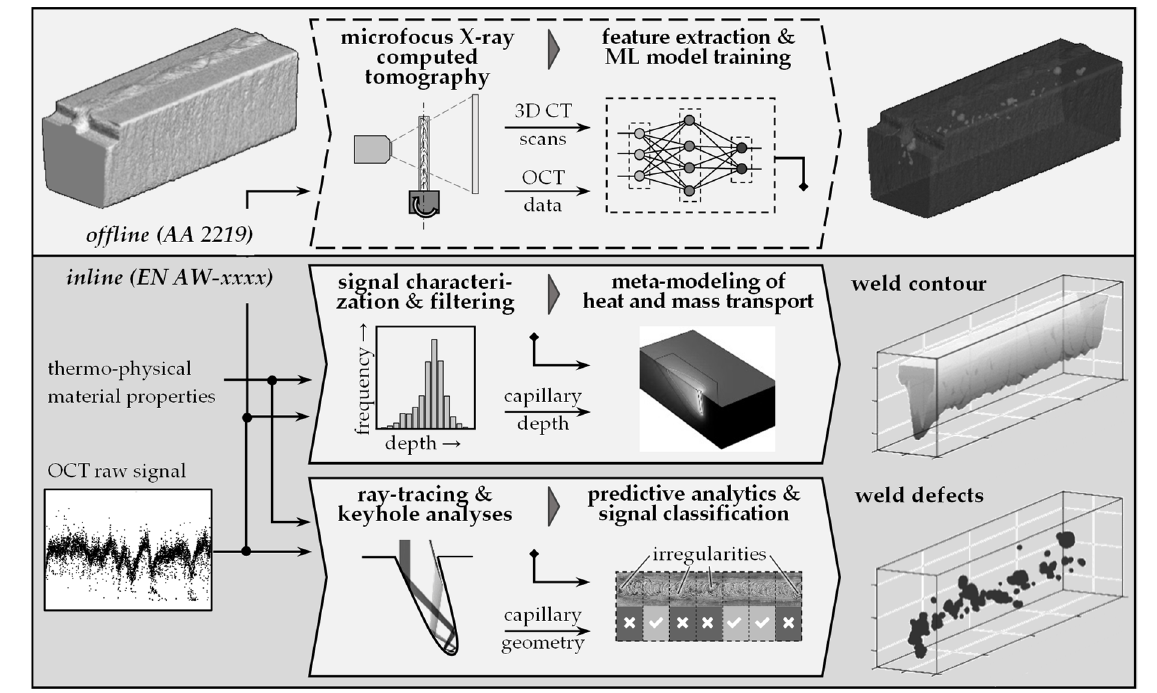
Figure 10. Approach for the transfer of the findings from the 3D characterization of welds based on AA 2219 to other materials using simulation and Machine Learning (ML) methods.